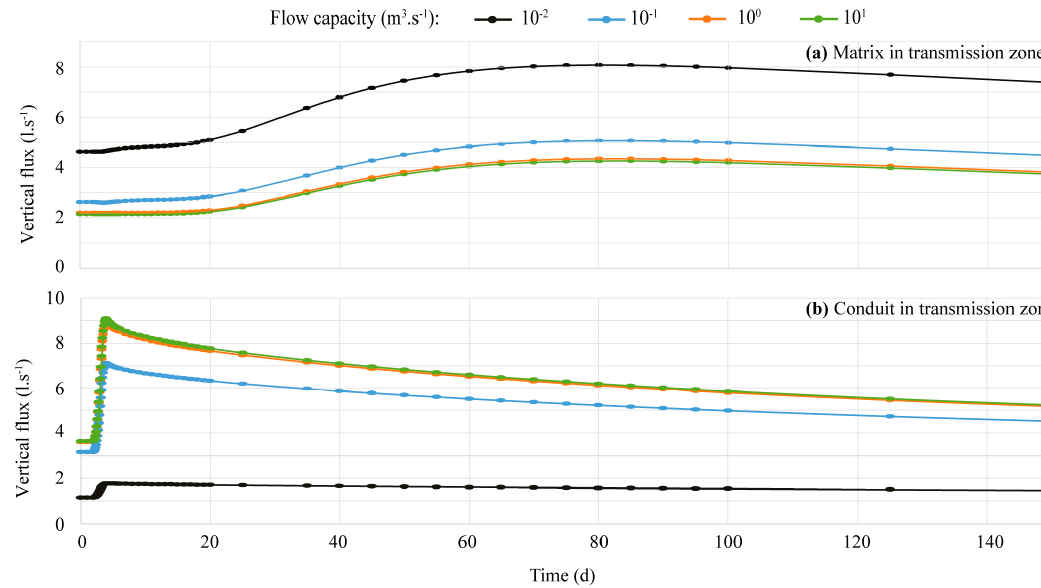
Figure 4. Vertical flux through the horizontal plane at the base of the transmission zone as a function of time, in the matrix ( a ) and conduit ( b ) respectively, for four values of flow capacity in the conduit.